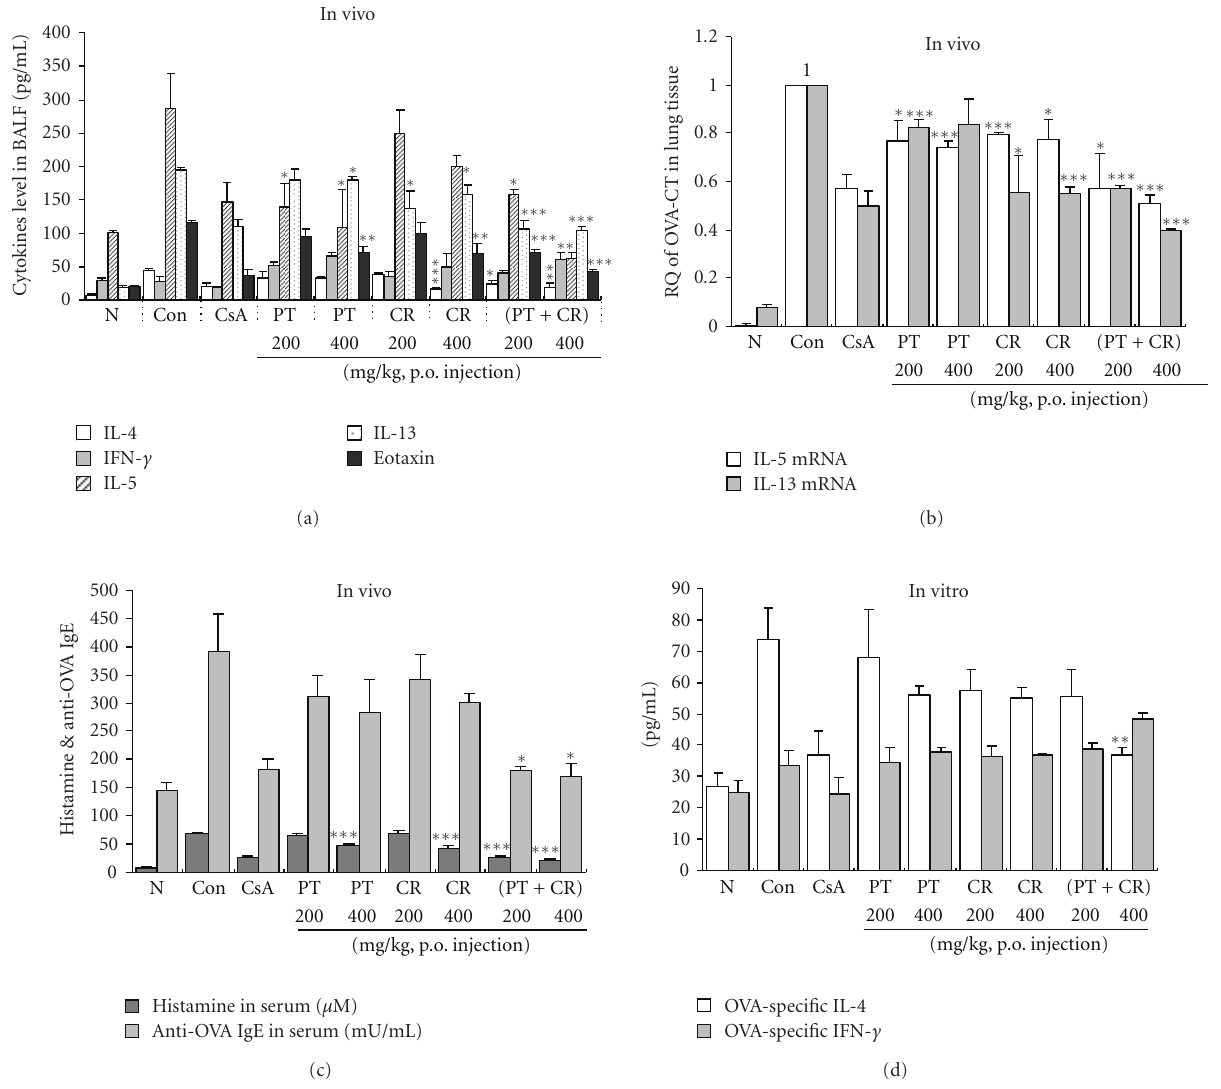
Figure 4: (a), (c), E ff ect of Pinellia ternata , Citrus reticulata and their combinational prescription on Th2 cytokines (IL-4, IL-5, IL- 13), Th1 cytokine (IFN- γ ), eotaxin in BALF and IgE, histamine level in serum. (b), E ff ect of Pinellia ternata , Citrus reticulata and their combinational prescription on IL-5, IL-13 mRNA gene expression in lung tissue of OVA-induced murine model of asthma (seen materials and methods). (d), Immunomodulatory e ff ects of Pinellia ternata , Citrus reticulata and their combinational prescription on OVA-specific Th1/Th2 cytokines production in spleen cells (described in materials and methods). The results are expressed the mean ± S.E ( N = 5). Statistically significant value compared with control group data by ANOVA or unpaired Student’s t -test ( ∗ P < . 05, ∗∗∗ P < . 001). N: Normal Balb/c mice, CT: Ovalbumin inhalation (control group), CsA: OVA + CsA (10mg/kg), OVA + PT(200, 400 mg/kg), OVA + CR(200, 400mg/kg), OVA + (PT + CR) (200, 400